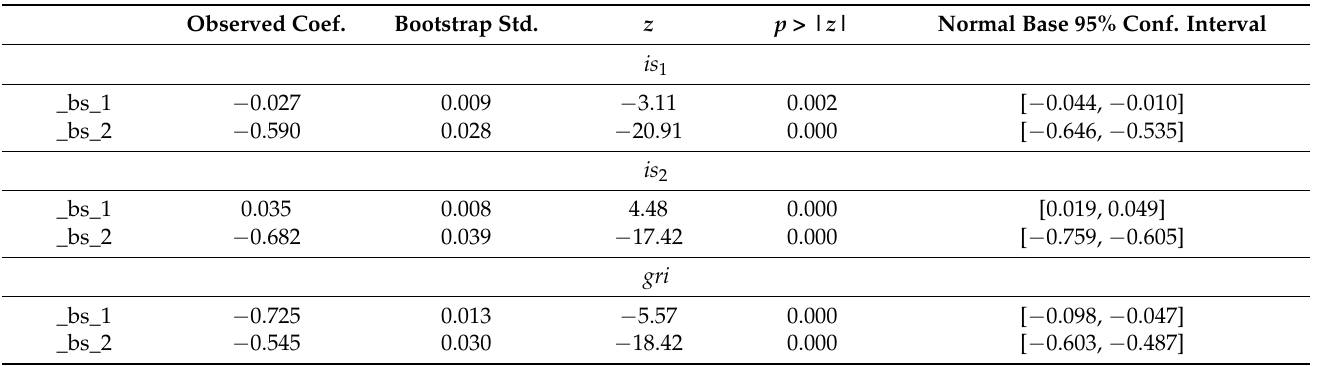
Table 9. Mediating effect test